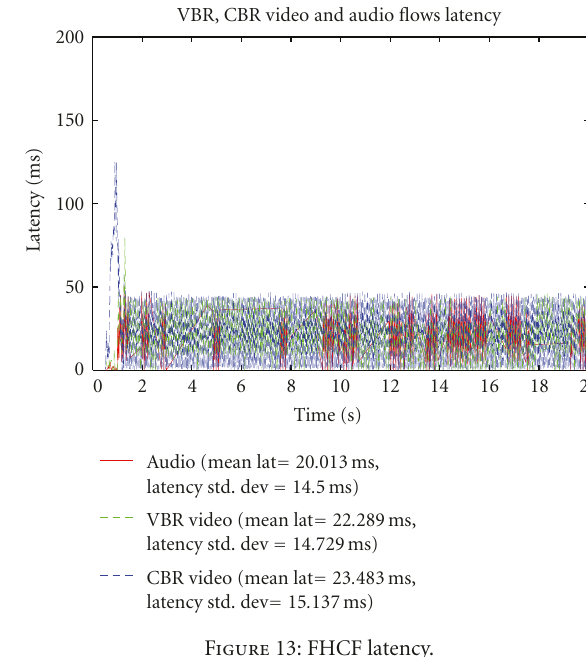
Figure 13: FHCF latency. Table 6: Dropped-packet number for di ff erent